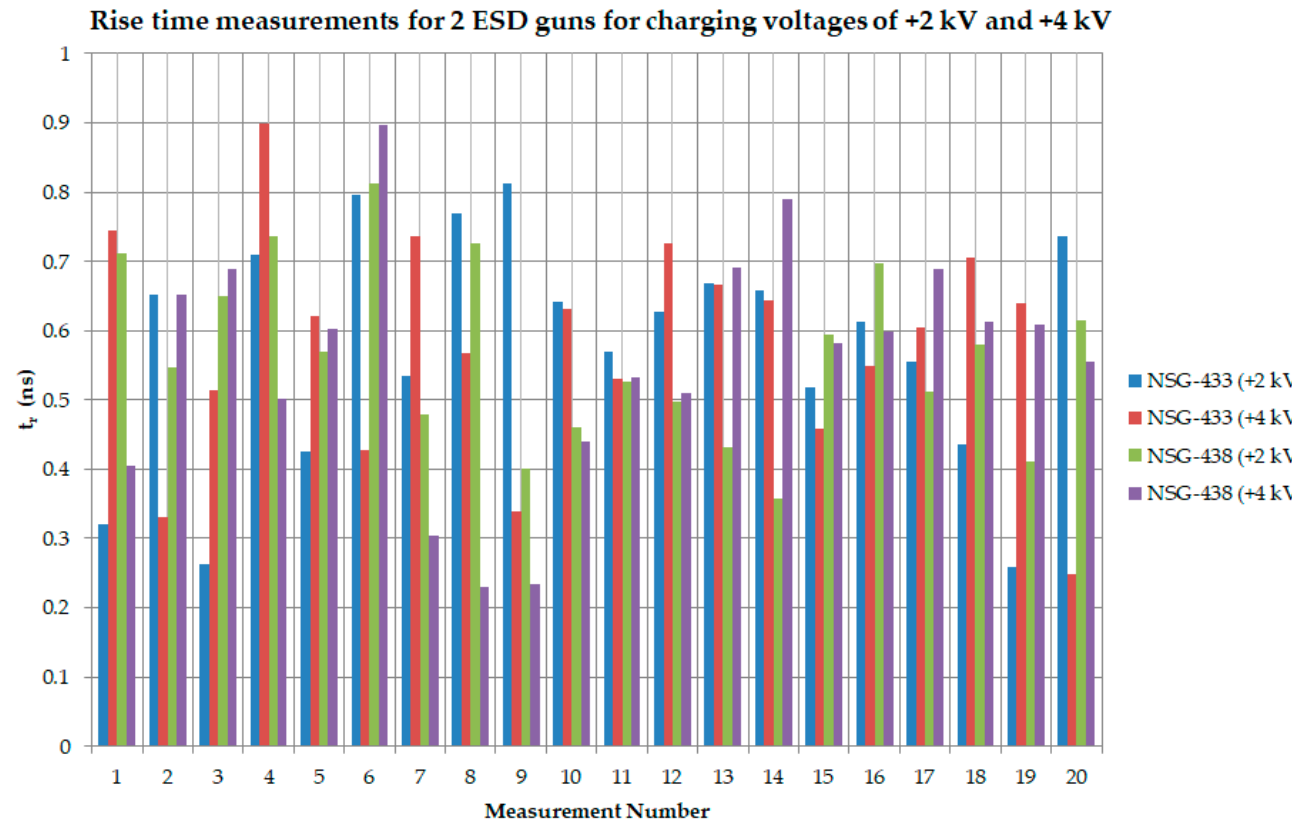
Figure 6. Rise time measurements for the two ESD guns for charging voltages of +2 kV and +4 kV.